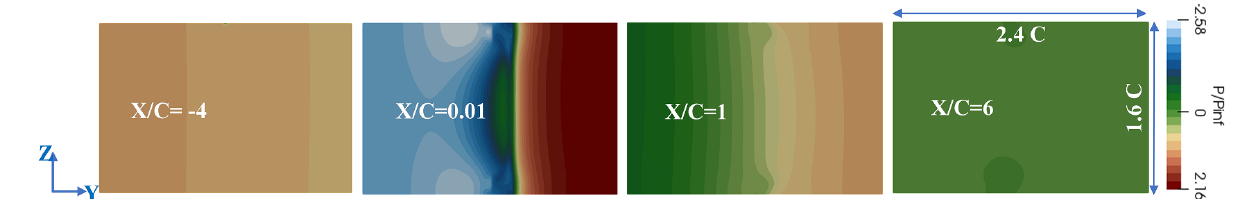
Figure 12. Spanwise confinement effect and its variation along the streamwise direction: P contour. The YZ planes are shown at the selected X location (see Figure 1). X = 0 denotes the TE location. P inf denotes the upstream pressure, where the outlet static pressure is set to zero.